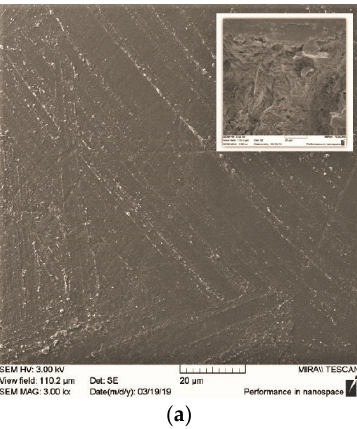
Figure 5. SEM photos of the surface and internal structure (inserts) of the solid phase of the CS·HCl : Pl F-127 = 30:70 (vol./vol.) hydrogels with С CS·HCl = 3 wt.%, С Pl F-127 = 25 wt.% without ( a ) and with the addition of 3 wt.% D-AscA ( b ).